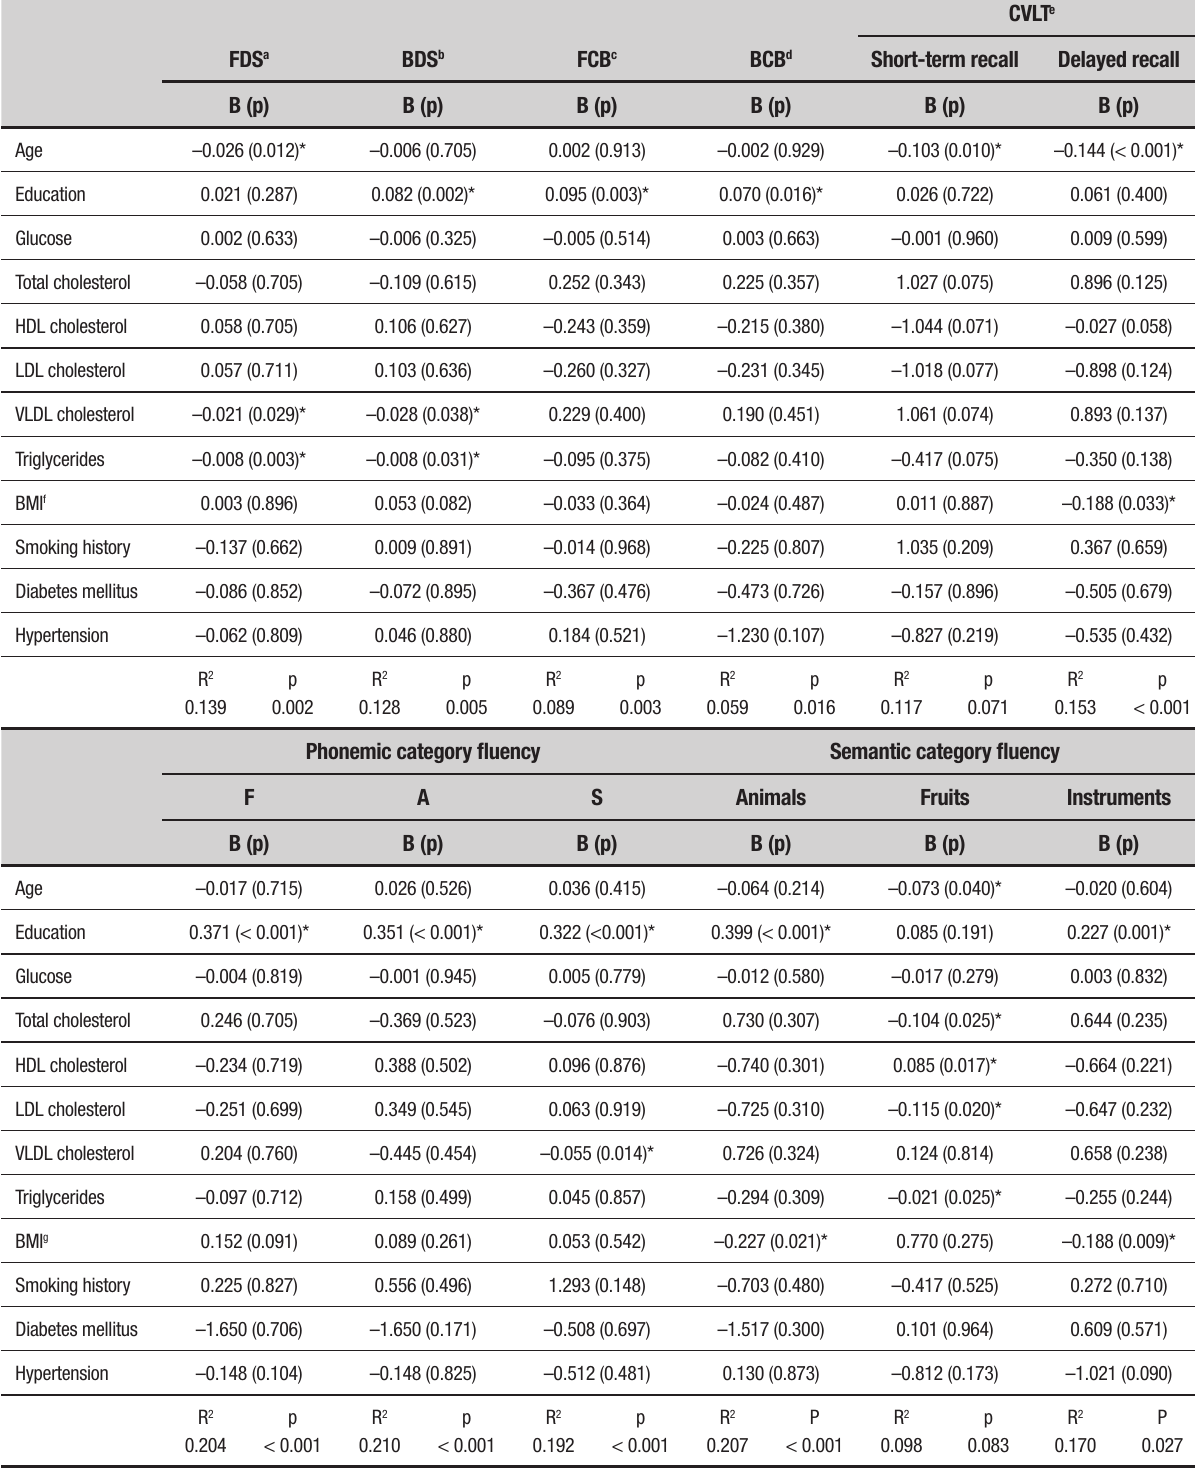
Table 2. Multivariate linear regression coefficients between cardiovascular risk factors and cognitive test